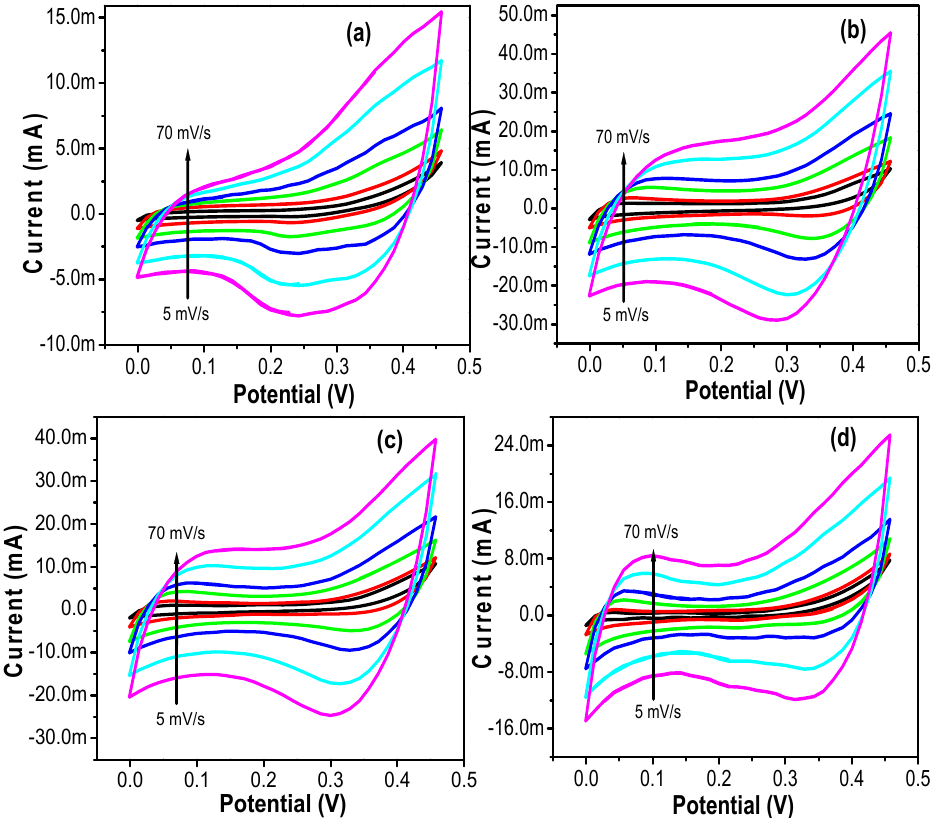
Figure 8. CV curves of the ( a ) SiCo-1-16; ( b ) SiCo-1-26; ( c ) SiCo-1-36; and ( d ) SiCo-2-36 LDH electrodes at different scan rates.